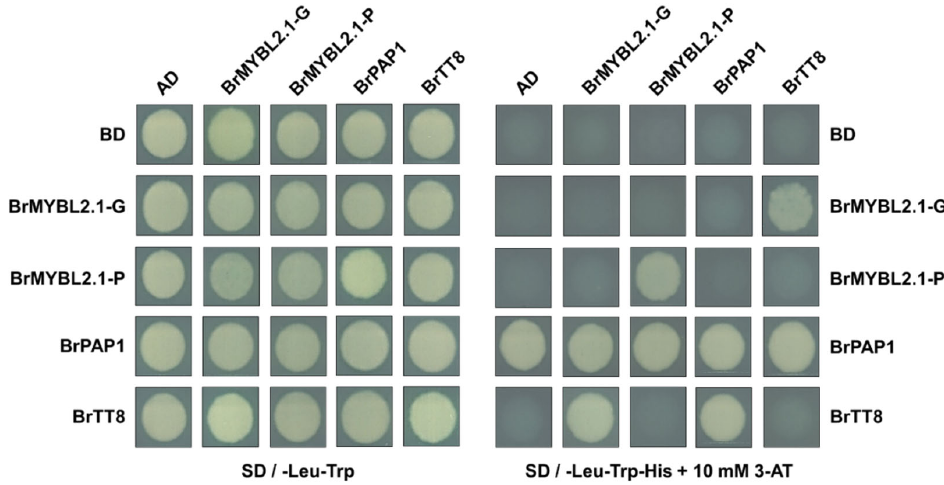
Figure 5. Interaction tests between BrMYBL2.1-G, BrMYBL2.1-P, BrPAP1, and BrTT8 by yeast two- hybrid assay. AD, activation domain; BD, binding domain; SD, synthetic defined medium; 3-AT, 3-amino-1,2,4-triazole; SD − TL, SD medium lacking Trp and Leu; SD − TLH + 3AT, SD medium lacking Trp, Leu, His and containing 10 mM 3-AT.